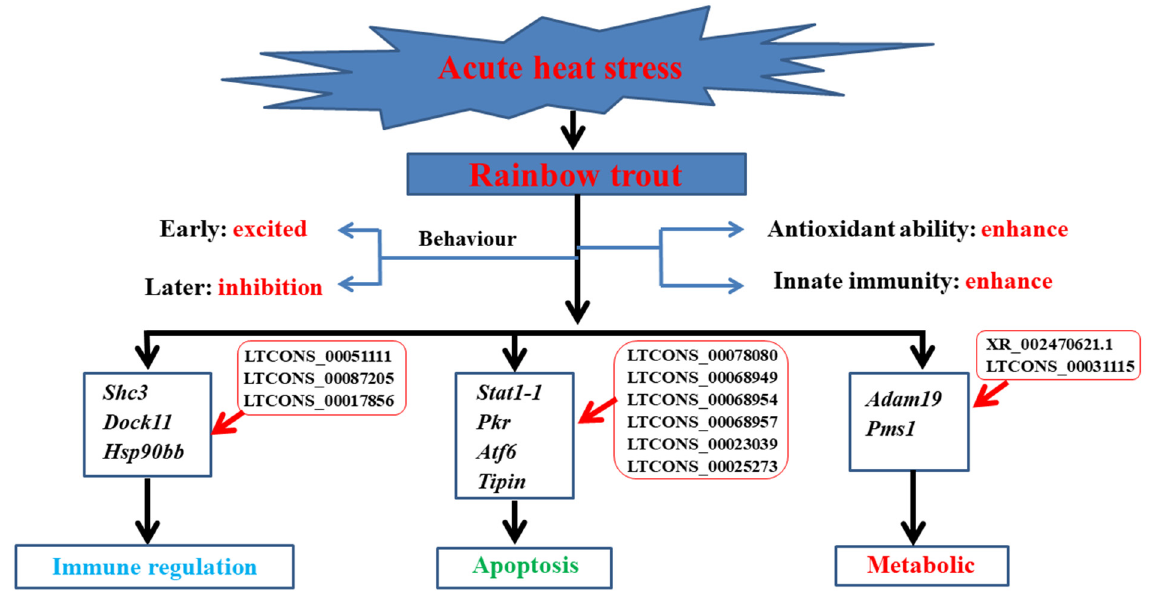
Figure 6. Diagram of regulated pathways in head kidney of rainbow trout exposed to 22.5 °C heat stress for 24 h. The pathways involved in immune regulation, metabolic, and apoptotic.